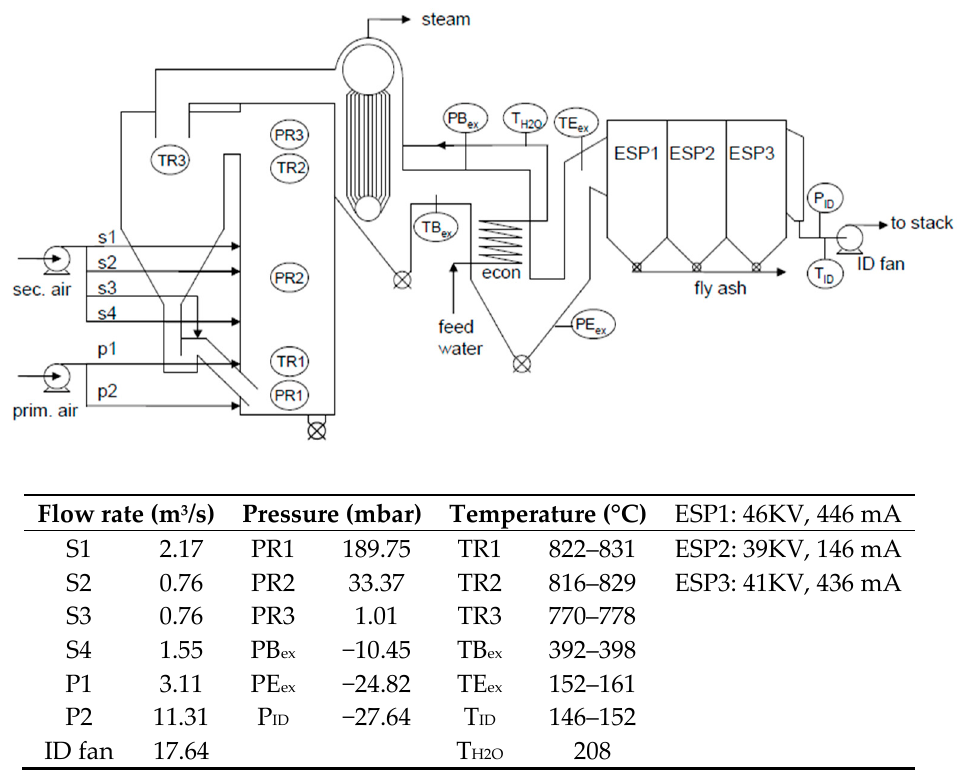
Figure 1. Flow-sheet and operating conditions of the 58 MW th circulating fluidized bed (CFB)-combustor at UPM-Kymmene (UK) Ltd., Caledonian paper mill, Irvine, Ayrshire, Scotland, UK [3] (Reprinted from [3], with permission from Elsevier, 2019.) Table 3. Relevant dimensions of the CFB.